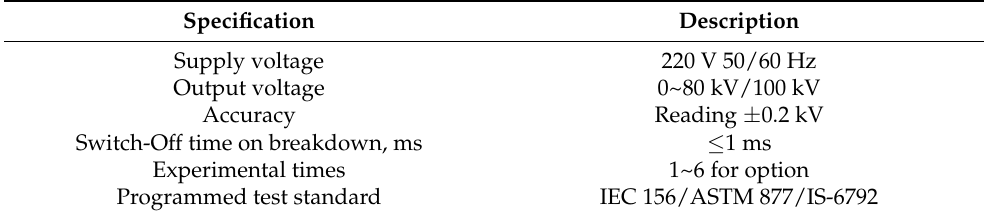
Table 3. Breakdown voltage tester.